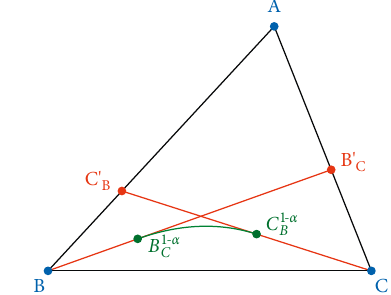
Figure 6: E ( ∠ A, ( 1 − α ) p ) ∩ D